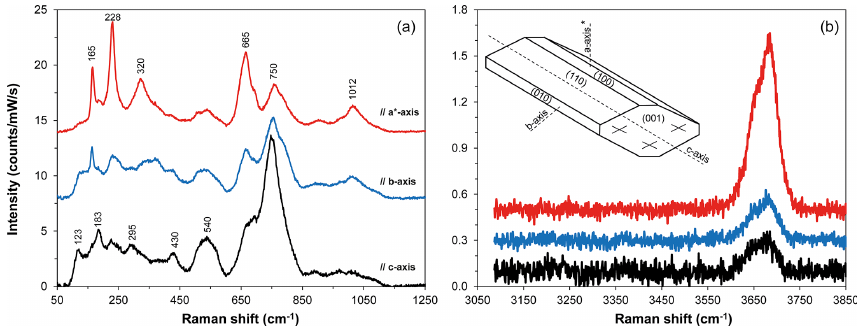
Figure 1. Polarized Raman spectra of the amphibole standard MGT4 in the regions of silicate network (a) and O–H stretching (b) vibrations, after baseline correction, as a function of the orientation of the crystal lattice relative to the polarization direction of the laser beam. The polarization of incident light was parallel to the polarization of scattered light. Polarized spectra were acquired on three orthogonal sections (100, 010, and 001). Representative spectra shown from bottom to top were collected, respectively, with the direction of laser polarization parallel to the c axis, b axis, and a axis ∗ . The a axis ∗ is distinguished from the true a axis because it is perpendicular to b axis and c axis. Note that the directions of the a axis and c axis do not coincide with those of the optical indicatrix axes in monoclinic amphiboles. The (top) spectrum with the most intense peaks at 228 and 665cm − 1 displays the strongest OH band, whereas the (bottom) spectrum with the maximum peak at 750cm − 1 is associated with the smallest OH band. Raman intensity was normalized to laser power and acquisition time. Spectra are vertically offset for clarity.